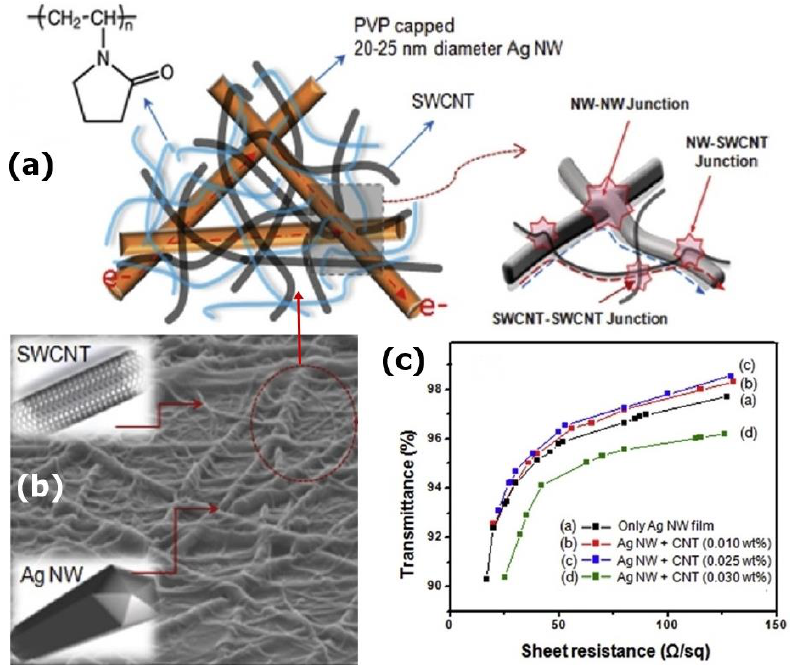
Figure 12. ( a ) Schematic illustration of the silver nanowire (Ag NW)–single-wall carbon nanotube (SWCNT) network and the conductive junctions of the composite. ( b ) SEM of the surface morphology of the Ag nanowire–nanotube composite. ( c ) Transmittance versus sheet resistance at different nanotube loading, which displays a performance comparable to ITO. (Reproduced by permission from ref. [152]).